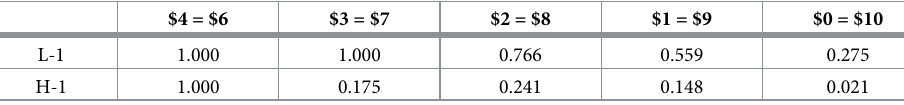
Table 8. Two-sided Fisher p